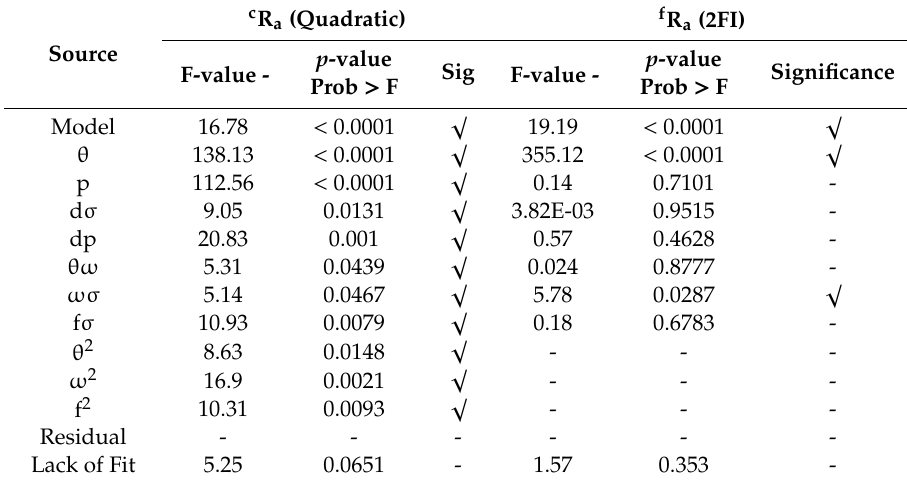
Table 3. Identification of influential parameters for the roughness on free and contact surfaces.